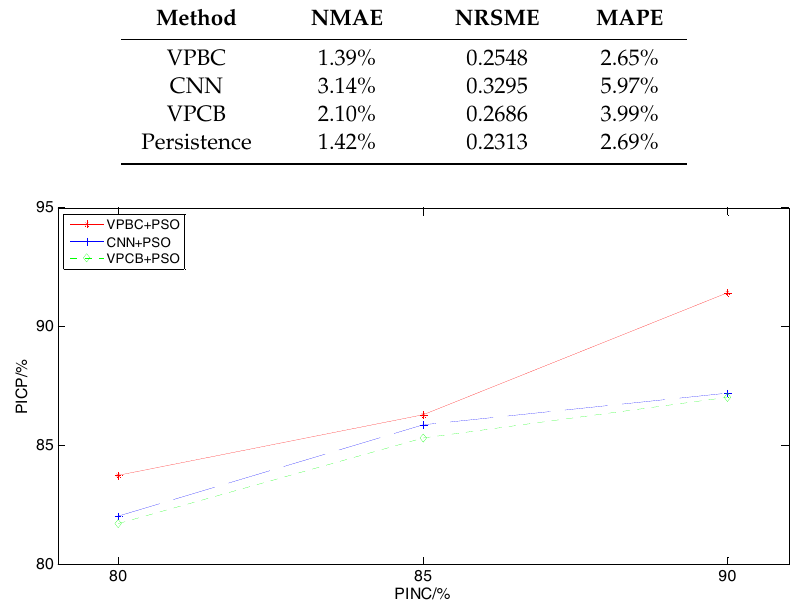
Table 4. Comparison of the forecasting error indices of the different methods.